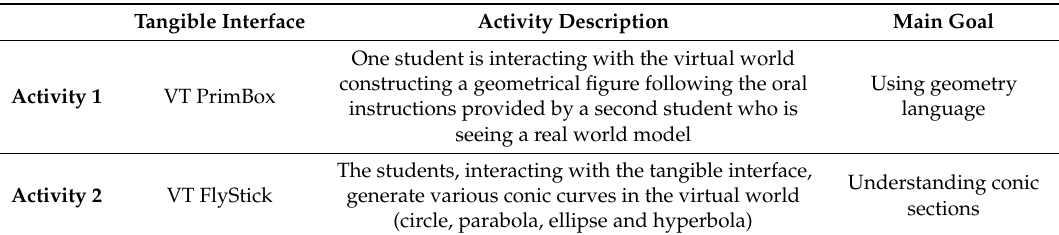
Table 1. Educational activities performed.